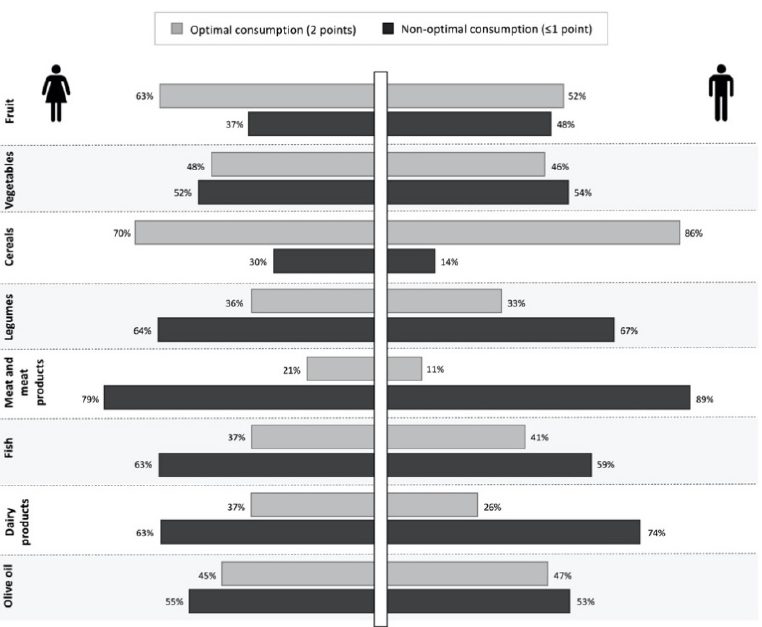
Figure 1. Percentages of girls and boys reporting optimal (2 points) and non-optimal ( ≤ 1 points) consumption of the individual food groups of the Medi-Lite score.